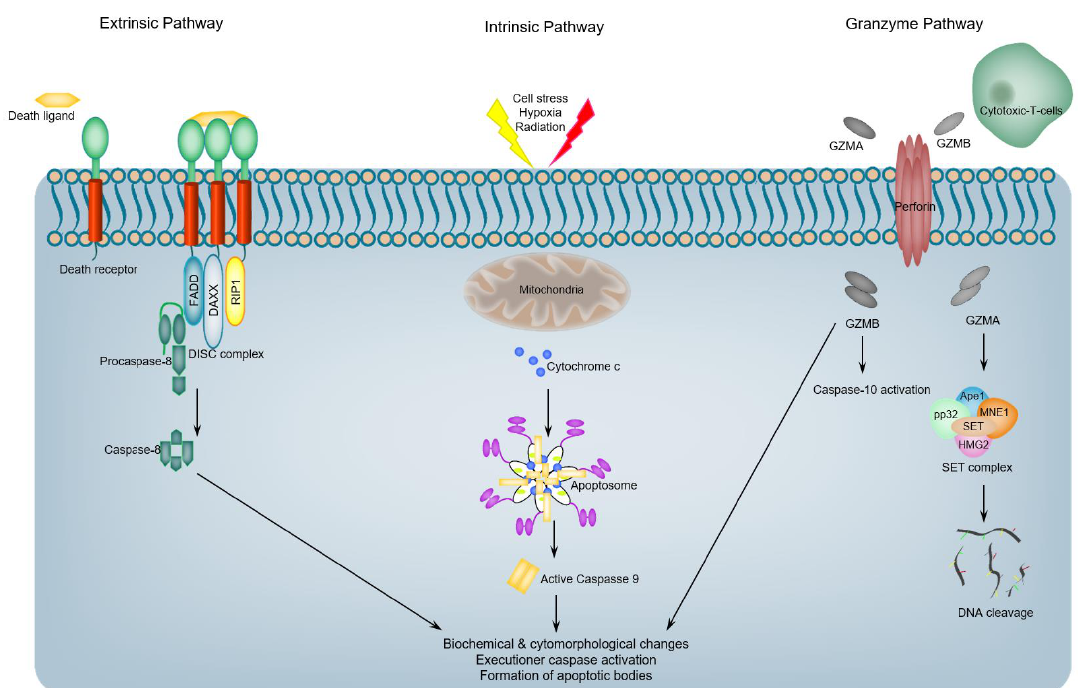
Figure 1. Three apoptotic pathways (Extrinsic, intrinsic and granzyme pathways). In the extrinsic pathway, the extrinsic apoptotic signaling pathway is triggered by ligation of a death receptor, followed by the assembly of a caspase activation platform called the DISC complex. This activation platform recruits and activates caspase-8 via adaptor molecules, and then subsequently leads to caspase 8-mediated activation of downstream effector caspases. In the intrinsic pathway, in response to various cellular stresses, pro-apoptotic proteins of the Bcl2 family mediate mitochondrial outer membrane permeabilization (MOMP), permitting the release of pro-apoptotic factors such as cytochrome c into the cytosol. Cytochrome c then binds to APAF1, mediating its oligomerization and recruitment of caspase 9 into the apoptosome, which in turn leads to the activation of caspase 9 and subsequent proteolytic activation of effector caspases. In the granzyme B pathway, the injection of granzyme B by cytotoxic T-Cells can lead to the direct proteolytic activation of caspase 10, among other targets, which subsequently leads to the activation of effector caspases.